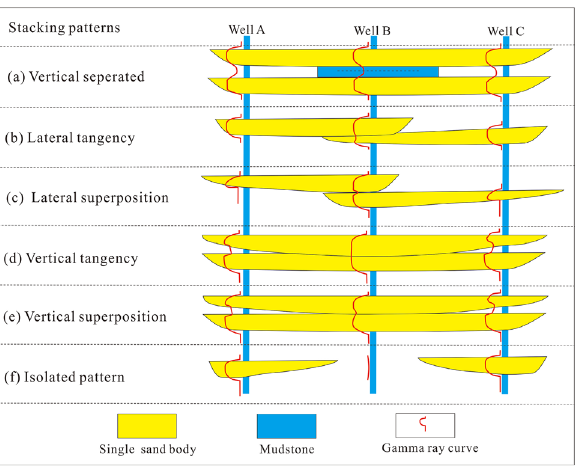
Fig. 10 Sandbodies stacking